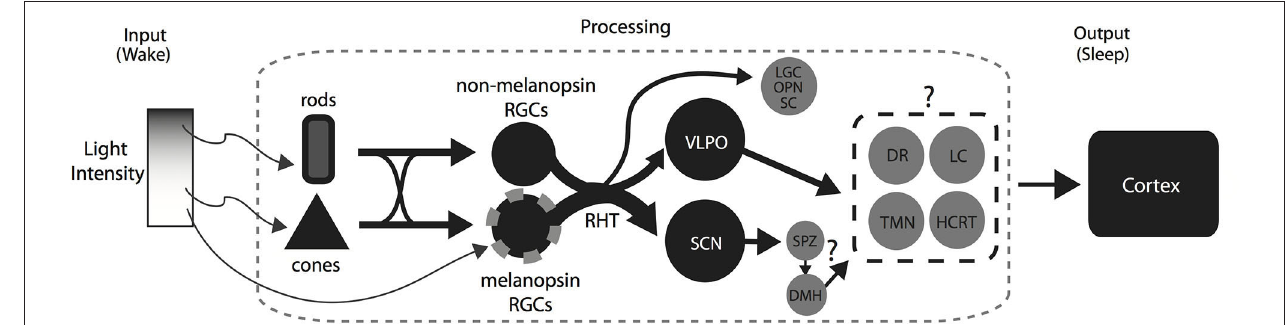
the inhibition of the wake promoting areas by the VLPO and presumably the SCN via the SPZ and DMH would facilitate the promotion of sleep by light at high intensities. However, it is not known whether the inhibition is across some or all of the wake promoting areas. Abbreviations: Retinal Ganglion Cells, RGCs; Retino-hypothalamic tract, RHT; Suprachiasmatic Nucleus, SCN; Ventrolateral Preoptic Area, VLPO; Lateral Geniculate Complex, LGC; Olivary Pretectal Nucleus, OPN; Superior Colliculus, SC; Dorsomedial hypothalamus, DMH; Dorsal Raphe, DR; Locus coeruleus, LC; Tubero-mammillary nucleus, TMN; Hypocretin,